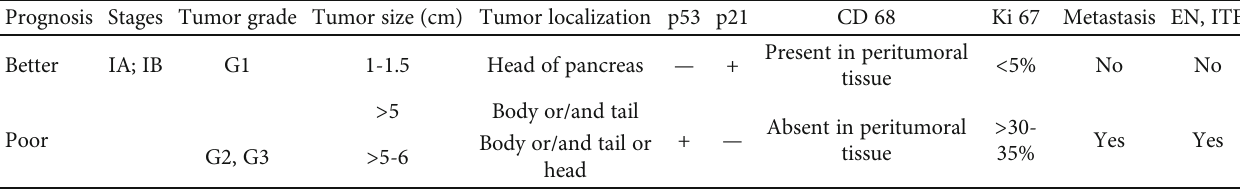
Table 3: Prognostic factors according to clinically, histopathologically, and immunohistochemically studied parameters (EN: endoluminal necrosis; ITE: intravascular tumoral